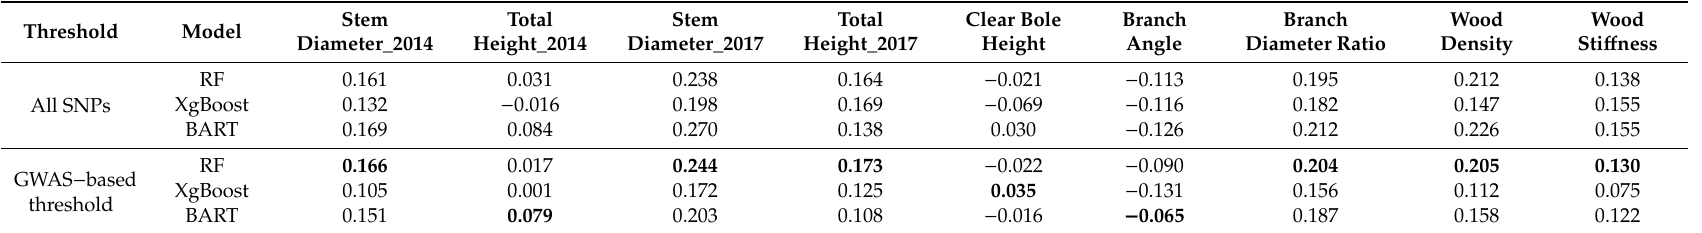
Table 4. Mean predictive ability of growth, branch and wood quality traits of the S. platyclados population derived using all SNPs and the best sets meeting GWAS-based criteria obtained with indicated Machine Learning models (RF, XgBoost and